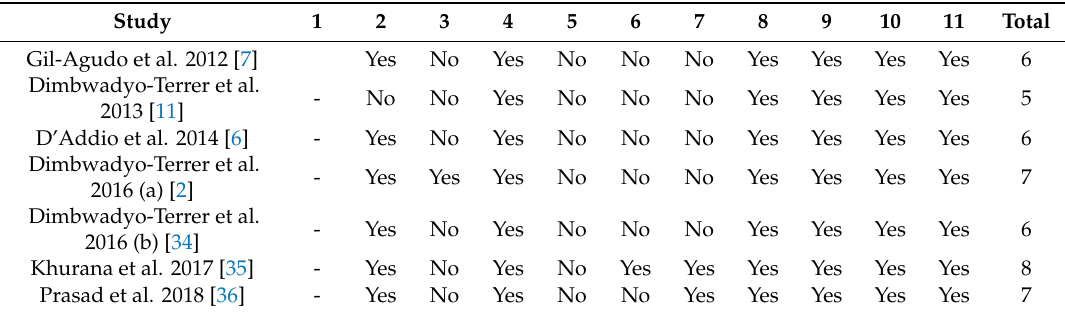
Range: 0–10. Item 1 is not used in the method